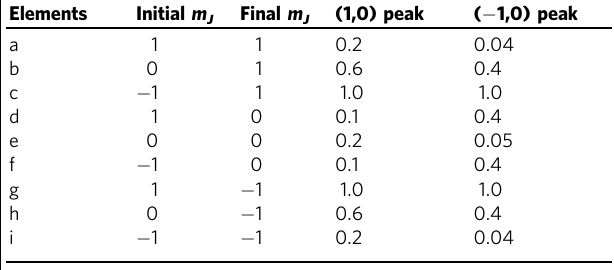
Table 1 Relative state-to-state scattering probabilities.